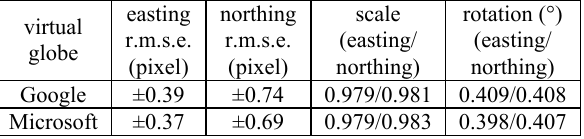
Table 1. Comparison of map geometry (Mercator projection) of virtual globes with Gauss-Krüger projection (M31) of the reference orthophotos. A 6-parameter (affine) transformation was used for geometric